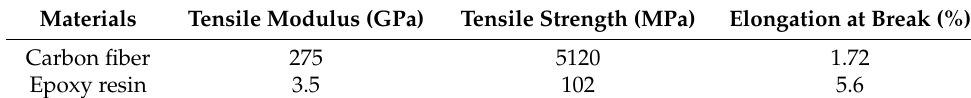
Table 1. Mechanical properties of the CCF800 carbon fiber and epoxy resin.